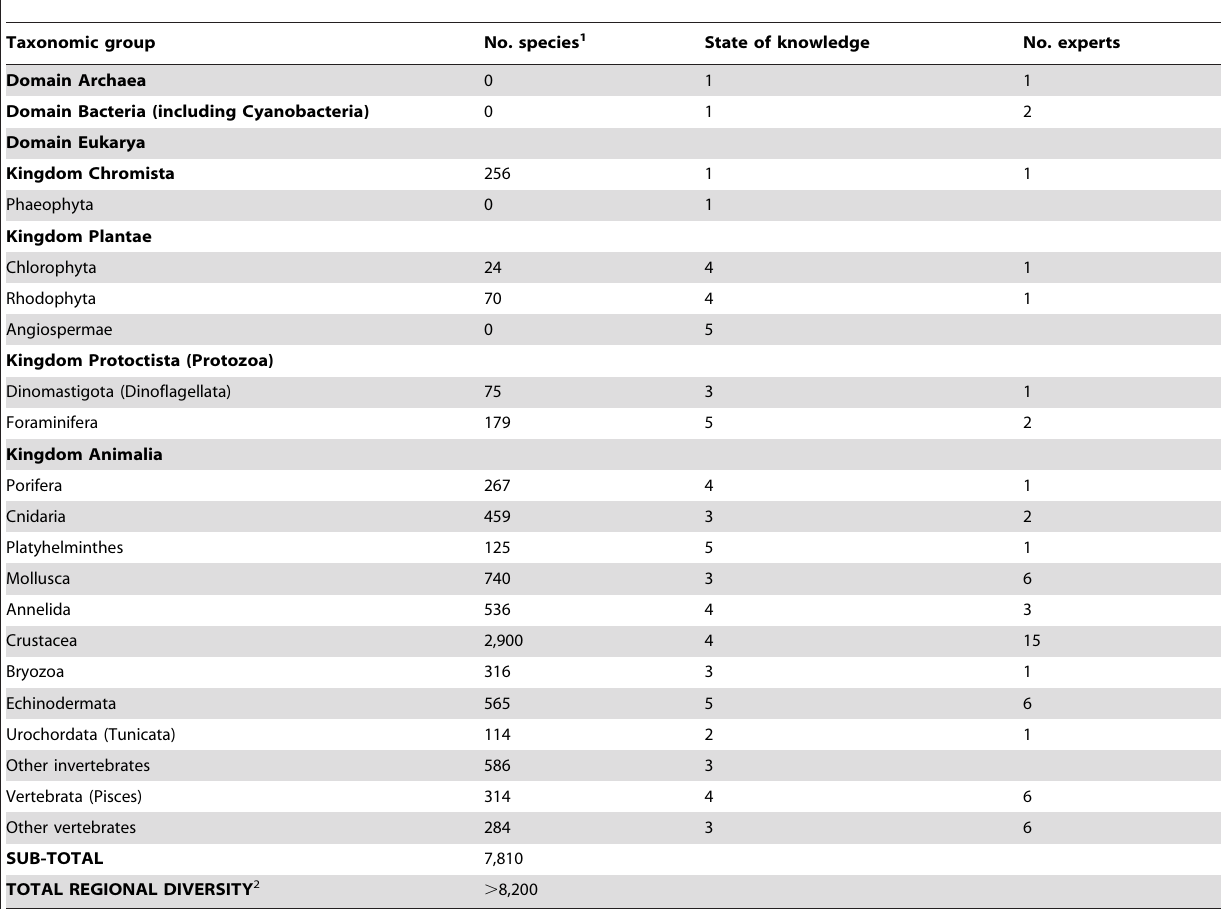
Table 1. Taxonomic expertise within the Antarctic study area and estimated numbers of described species per taxon.